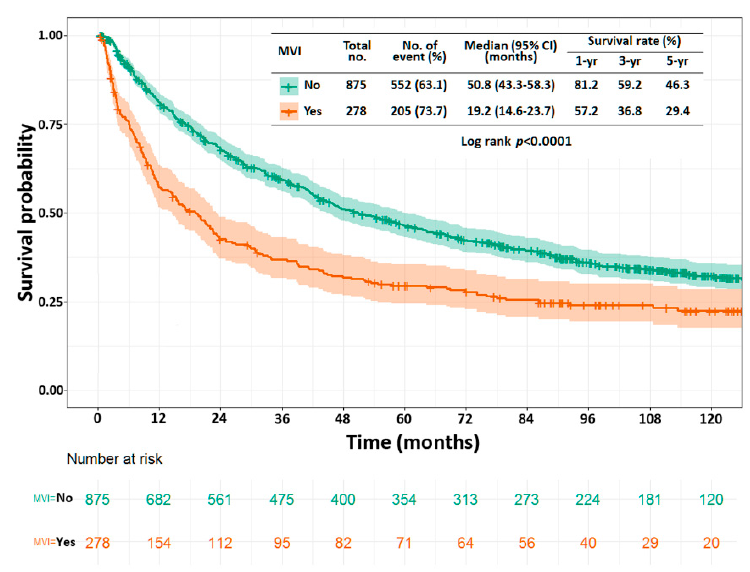
Figure 2. Kaplan–Meier curve for disease-free survival in patients with (red line) or without (green line) microvascular invasion.